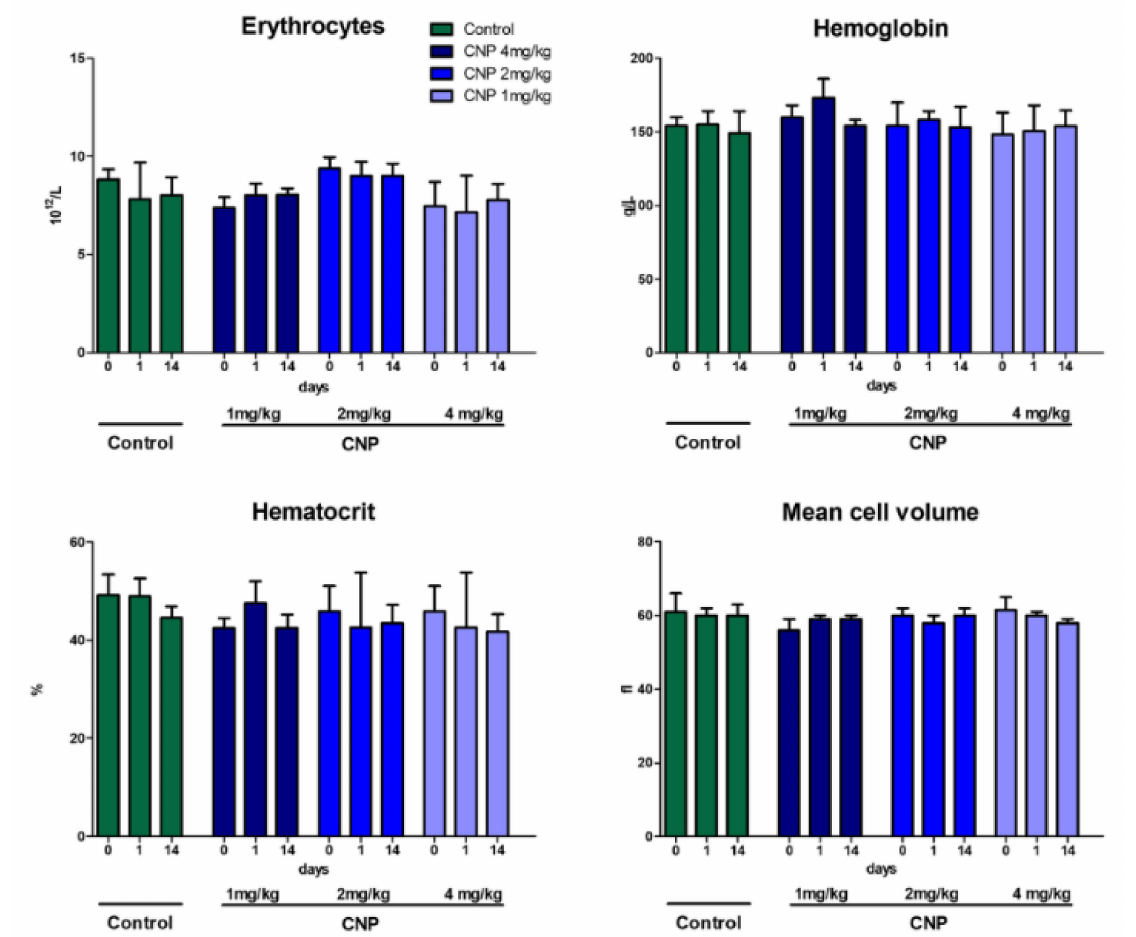
Figure 8. Dynamics of rat hemoglobin and erythrocyte parameters at di ff erent time points (0, 1 and 14 days) after intravenous injection of CNPs (1–4 mg / kg). Data represent the median ± range. These data complement results of the analysis of the level of free hemoglobin in the blood plasma of rats after administration of CNPs. If CNPs caused significant intravascular hemolysis and thrombosis, all red cell mass parameters (erythrocytes, hematocrit, and hemoglobin) can be decreased by CNPs–erythrocyte interactions, while MCV within normal range in the first day after intravenous administration of CNPs. The results of hematological analysis did not reveal significant changes in the parameters of red blood. Baseline parameters of the leukocyte pools were similar between the experimental groups. An increase in the leukocyte blood levels was observed at 1 day after the administration in all groups (Figure 9), which reflected a reaction to the surgical trauma of the femoral vein catheterization. After 2 weeks, the leukocyte levels returned to